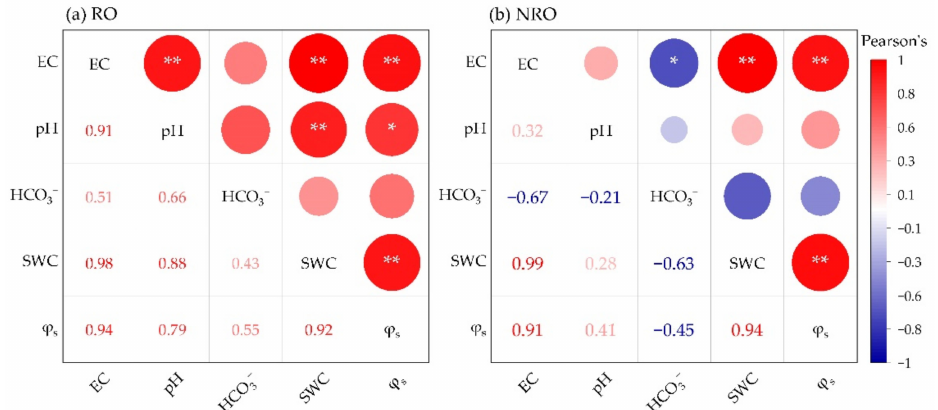
Figure 6. Pearson correlation coefficients between different parameters in soils of the two habitats. ( a ) indicates Pearson correlation analysis in rock outcrops habitat. ( b ) indicates Pearson correlation analysis in non-outcrops habitat. RO and NRO represent the rock outcrops habitat and the non- outcrops habitat, respectively. ** Correlation is significant at the 0.01 level (2-tailed). * Correlation is significant at the 0.05 level